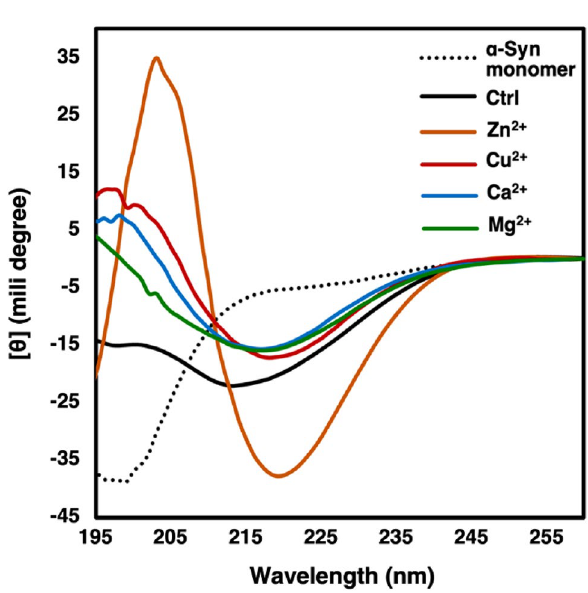
Figure 2. Far-UV CD spectra of α-Syn monomer and fibrils formed in the presence and absence of each cation. The fibrils formed by 100 µM α-Syn in 20 mM Tris buffer (pH 7.5) or in presence of 500 µM of the metal cations were analyzed. The measurements were carried out in room temperature (25 °C). See materials and methods for